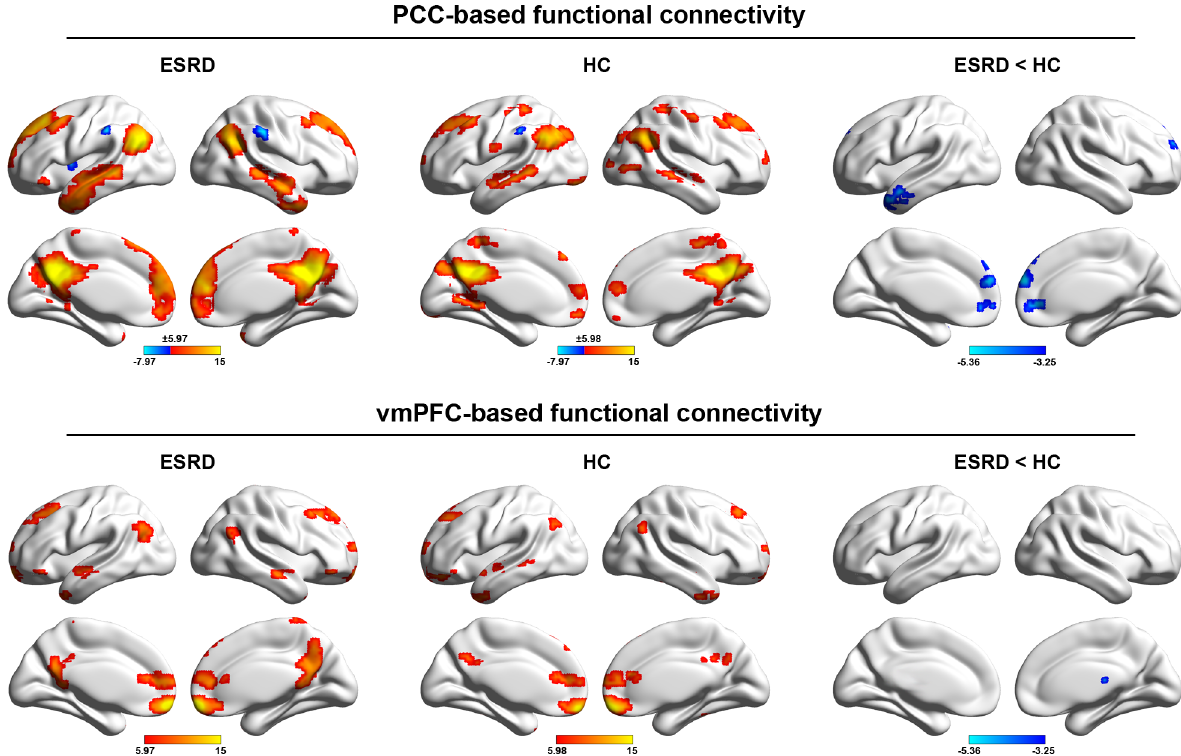
Fig 1. Within-group DMN patterns and between-group differences. The color bars represent the T scores. The results were mapped onto the brain surface using the BrainNet viewer software.